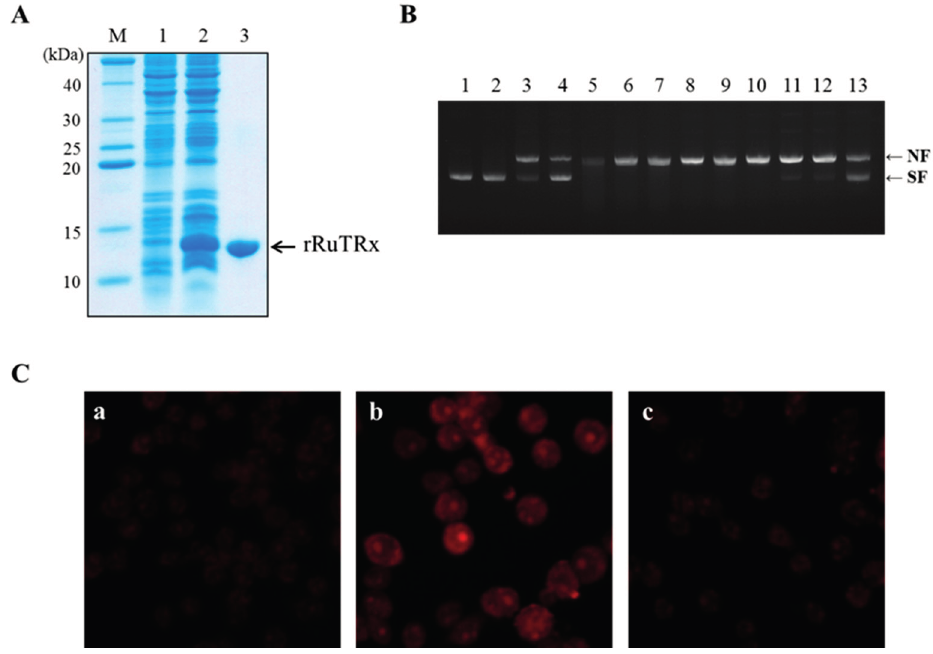
Figure 5. Expression and antioxidant activity of purified recombinant RuTrx protein under oxidative stress. ( A ) SDS-PAGE analysis of recombinant RuTrx protein. Protein samples were separated by 15% SDS-PAGE. Lane M, protein marker; Lane 1, non-induced pellet; Lane 2, 1 mM IPTG-induced supernatant; Lane 3, purified recombinant RuTrx protein; ( B ) Protective property of recombinant RuTrx protein against DNA cleavage from oxidative stress. Lane 1, pUC19 with no incubation; Lane 2, pUC19 and water; Lane 3, pUC19 and 20 μ M FeCl 3 ; Lane 4, pUC19, 2.5 mM DDT and water; Lane 5, pUC19, 20 μ M FeCl 3 , 2.5 mM DDT and water; Lane 6, pUC19, 20 μ M FeCl 3 , 2.5 mM DDT, water and BSA (50 μ g/mL); Lane 7, pUC19, 20 μ M FeCl 3 , 2.5 mM DDT, water and rRuTrx (50 μ g/mL), Lane 8, pUC19, 20 μ M FeCl 3 , 2.5 mM DDT, water and BSA (100 μ g/mL); Lane 9, pUC19, 20 μ M FeCl 3 , 2.5 mM DDT, water and rRuTrx (100 μ g/mL); Lane 10, pUC19, 20 μ M FeCl 3 , 2.5 mM DDT, water and BSA (200 μ g/mL); Lane 11, pUC19, 20 μ M FeCl 3 , 2.5 mM DDT, water and rRuTrx (200 μ g/mL); Lane 12, pUC19, 20 μ M FeCl 3 , 2.5 mM DDT, water and BSA (400 μ g/mL); Lane 13, pUC19, 20 μ M FeCl 3 , 2.5 mM DDT, water and rRuTrx (400 μ g/mL). Samples in Lanes 2 to 13 were incubated for 1 h at 37 ° C. NF, nicked form of pUC19; SF, supercoiled form of pUC19; ( C ) Effects of recombinant RuTrx protein on reducing ROS in Raw264.7 cells. DHE staining was performed to detect ROS in Raw264.7 cells after incubation with 10 μ g/mL of rRuTrx for 24 h and treatment with H 2 O 2 for 24 h. Fluorescence was detected under a microscope (Axiovert A1; Zeiss) with a 40× objective lens coupled to a digital camera. Representative fluorescence images of cells are shown: ( a ) vehicle-treated cells; ( b ) treated with 500 μ M H 2 O 2 ; ( c ) treated with 10 μ g/mL rRuTrx and 500 μ M H 2 O 2 . The red fluorescence intensity indicates the relative levels of ROS present in the